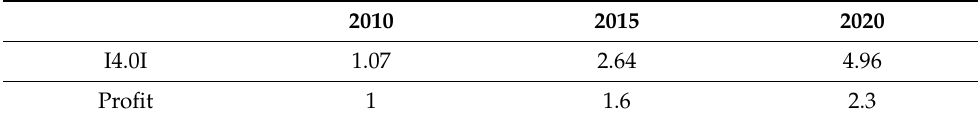
Table 7. Company A’s calculated I4.0I and profit comparison.